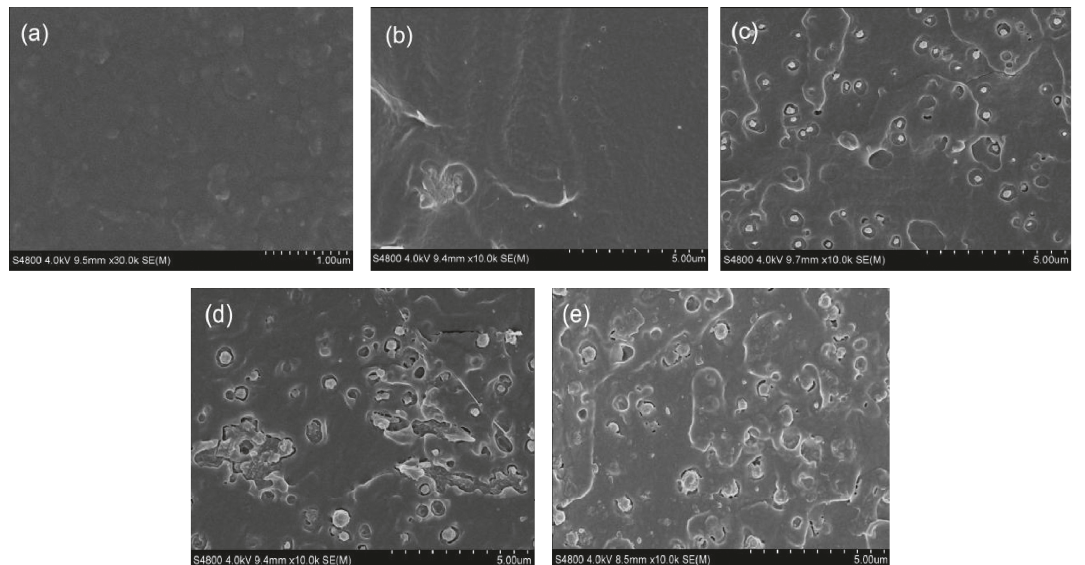
Figure 2: FE-SEM micrographs of the PLA nanocomposites: (a) pure PLA, (b) PLA/mNCC-2, (c) PLA/mNCC-4, (d) PLA/mNCC-6, and (e)